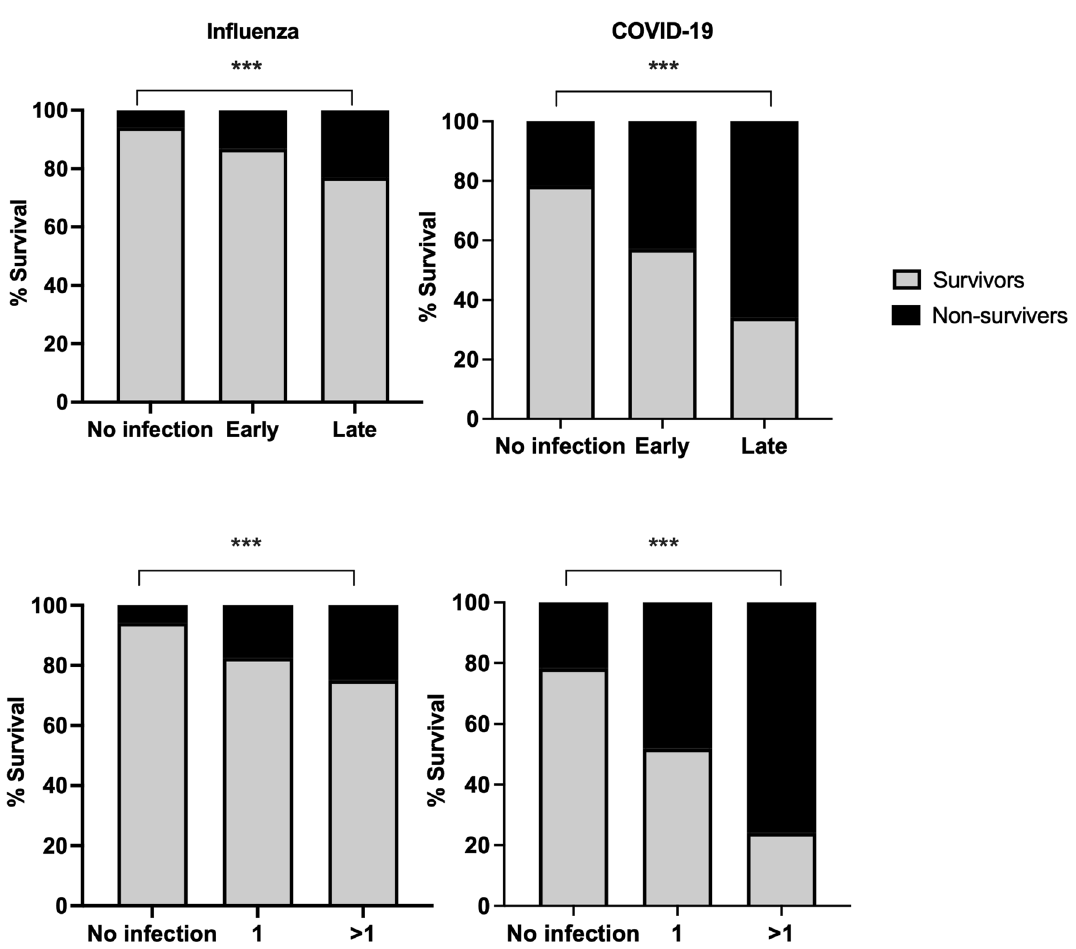
Figure 2. Association of coinfection variables with disease outcome. Stacked graphs are presenting the percentage of surviving or non-surviving coinfected patients in both groups. The top graphs compare survival rates in each group according to the time of infection, while the lower graphs compare the survival rates according to the number of infections. Chi-Square Test was used to compare the categorical variables, ***, p < groups. In the group of patients without bacterial infection 13.2% of the patients died while 27.7% of patients